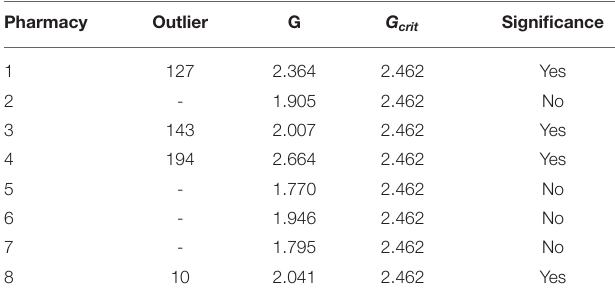
TABLE 14 | The results of Grubbs’ tests by pharmacies (product with